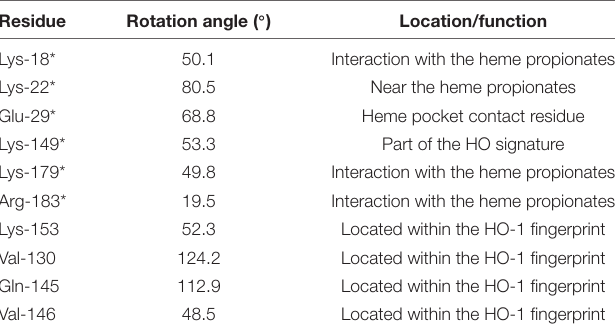
TABLE 3 | Residues of bottlenose dolphin heme oxygenase 1 (HO-1) with different rotation than that in human HO-1.